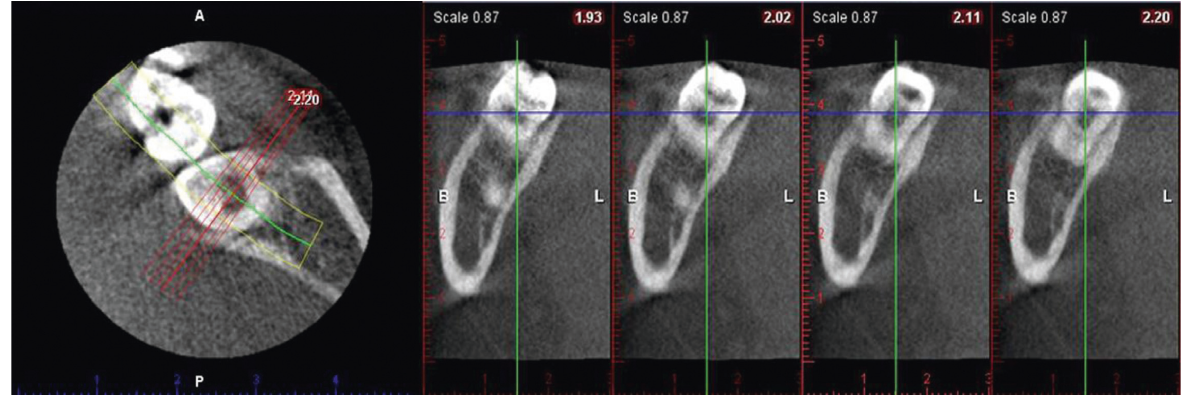
Figure 3: Sagittal slices of the PEIR-affected tooth (permanent mandibular left second molar) reconstructed from the first CBCT when the patient was 11 years, 5 months old. PEIR presented as an obvious radiolucency within the dentin with no direct exposure of the lesion or dentin to the oral cavity. The distance from the midfloor of the lesion to the roof of the pulpal area was 1.58 mm. The PEIR dimension is 3.75mm occluso-gingival depth, 5.52mm bucco-lingual width, and 3.05mm mesio-distal